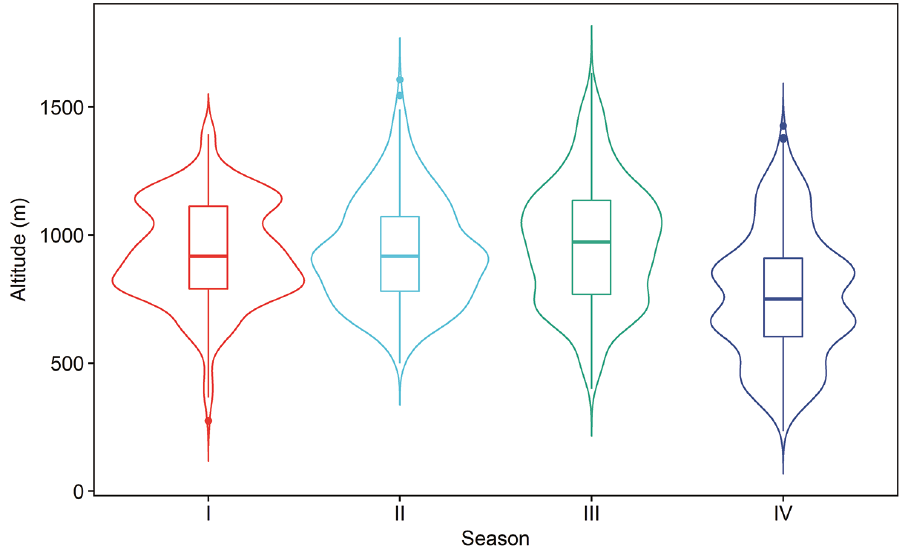
Figure 7. Seasonal variation of the altitude of brown bear locations in Eastern Romanian Carpathians and Subcarpathians: I – Winter sleep ; II – Den exit and reproduction ; III – Forest fruits ; IV – Hyper- phagia. (Horizontal line = median value, box = interquartile range, the vertical width = density of the data within a season, points =